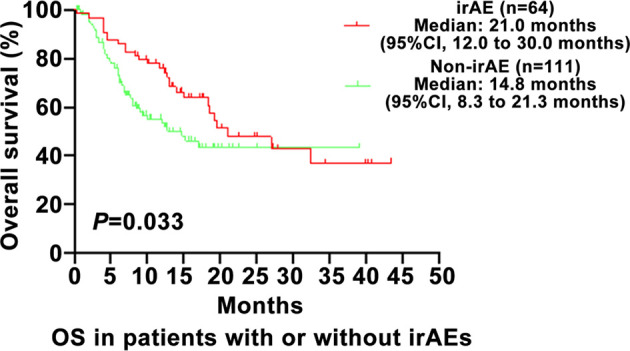
Impact of immune-related adverse events (irAEs) on overall survival (OS). OS, overall survival; CI, confidence interval; irAE, immune-related adverse events; P-values <0.05 were considered statistically significant.